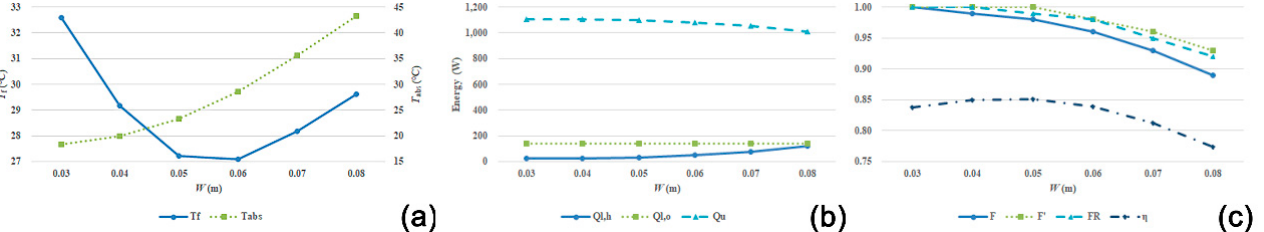
Figure 13. Influence of W. ( a ) Dependence between T f , T abs , and W . ( b ) Dependence between energy, and W . ( c ) Dependence between efficiency parameters, and W .